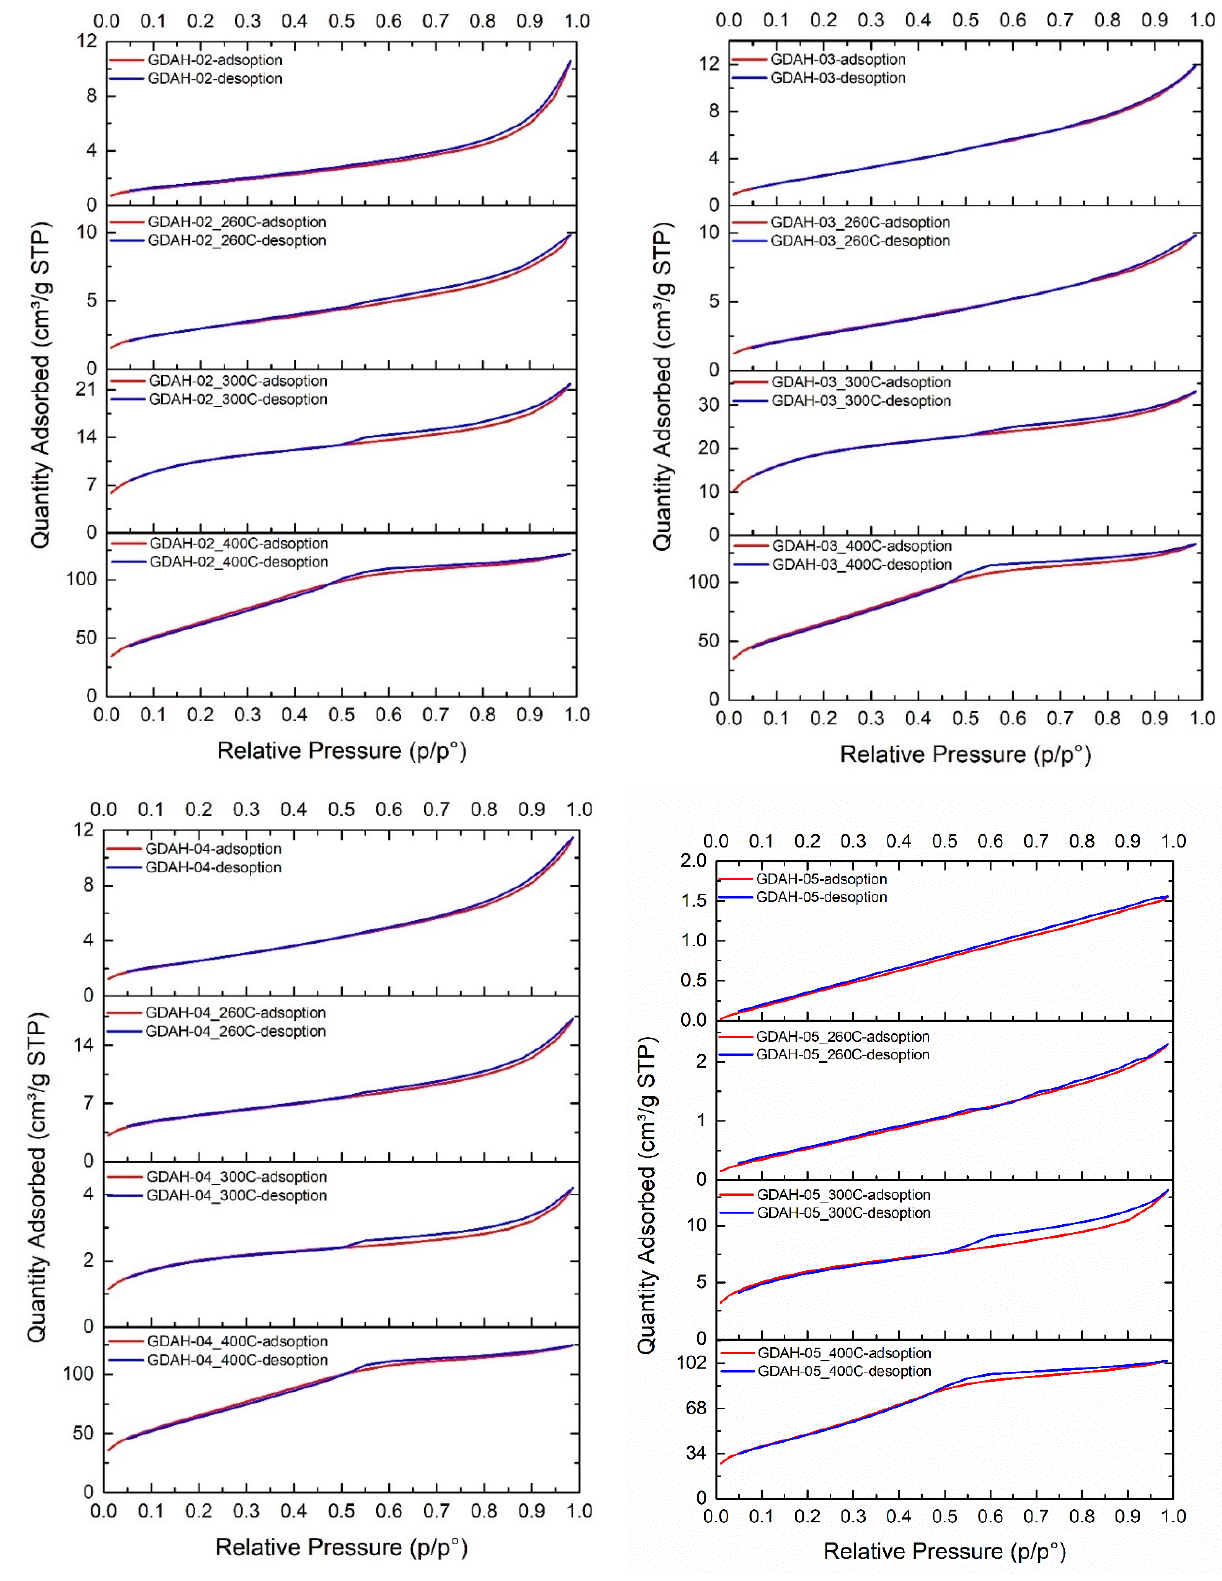
Figure 7. Nitrogen adsorption − desorption BET isotherms of the initial samples and of the samples after the thermal treatment at 260, 300, or 400 °C for 2 h.